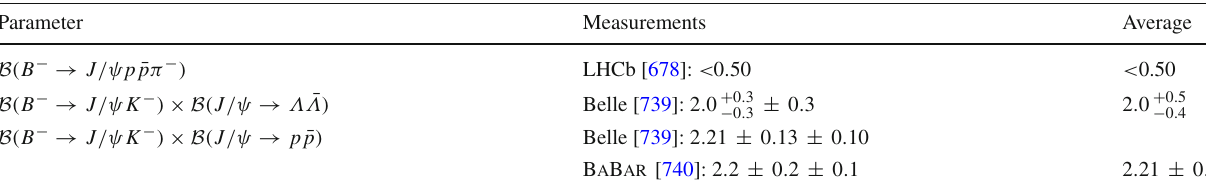
Table 167 Decays with baryons II [ 10 − 6